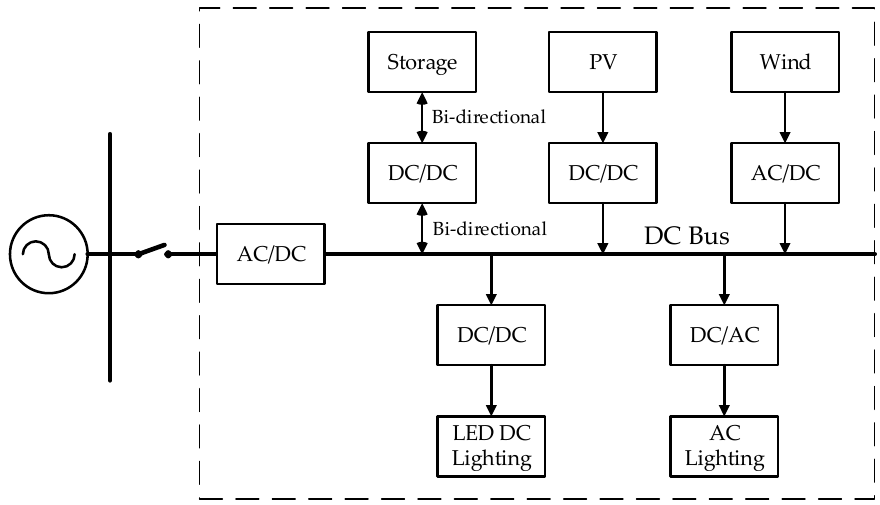
Figure 2. The architecture of a street lighting pole with renewable energy.